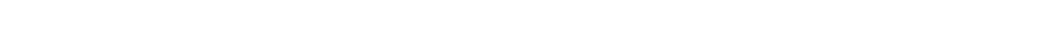
Frontiers in Endocrinology | Endocrinology of